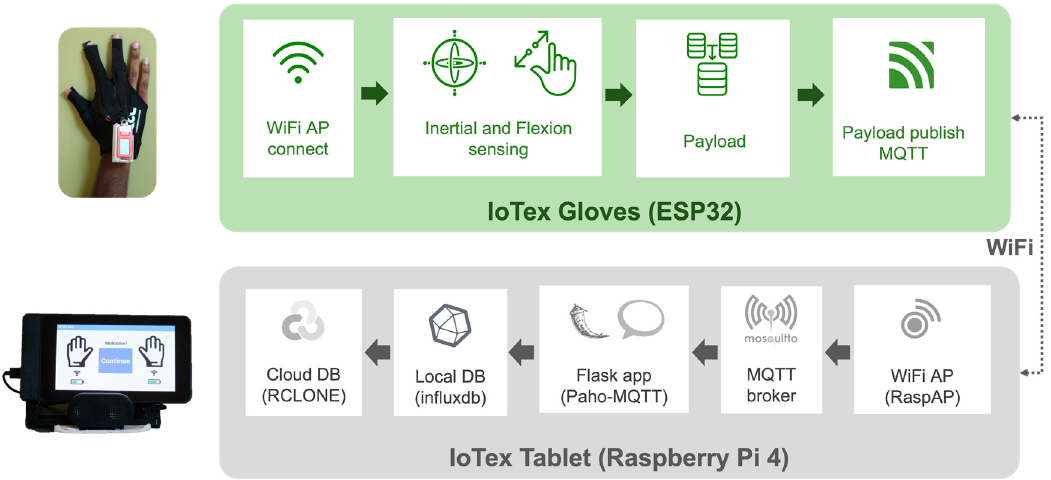
Figure 5. System architecture of iTex glove data collection system. Table 1. Movement task instruction details.